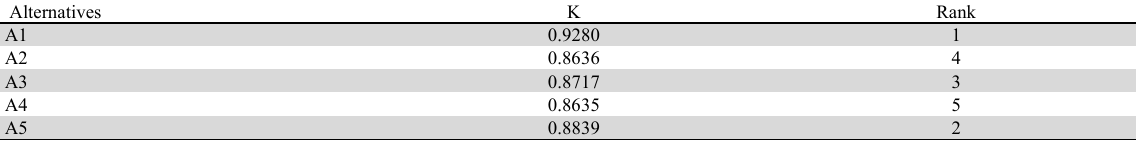
COCOSO ranking of the measures